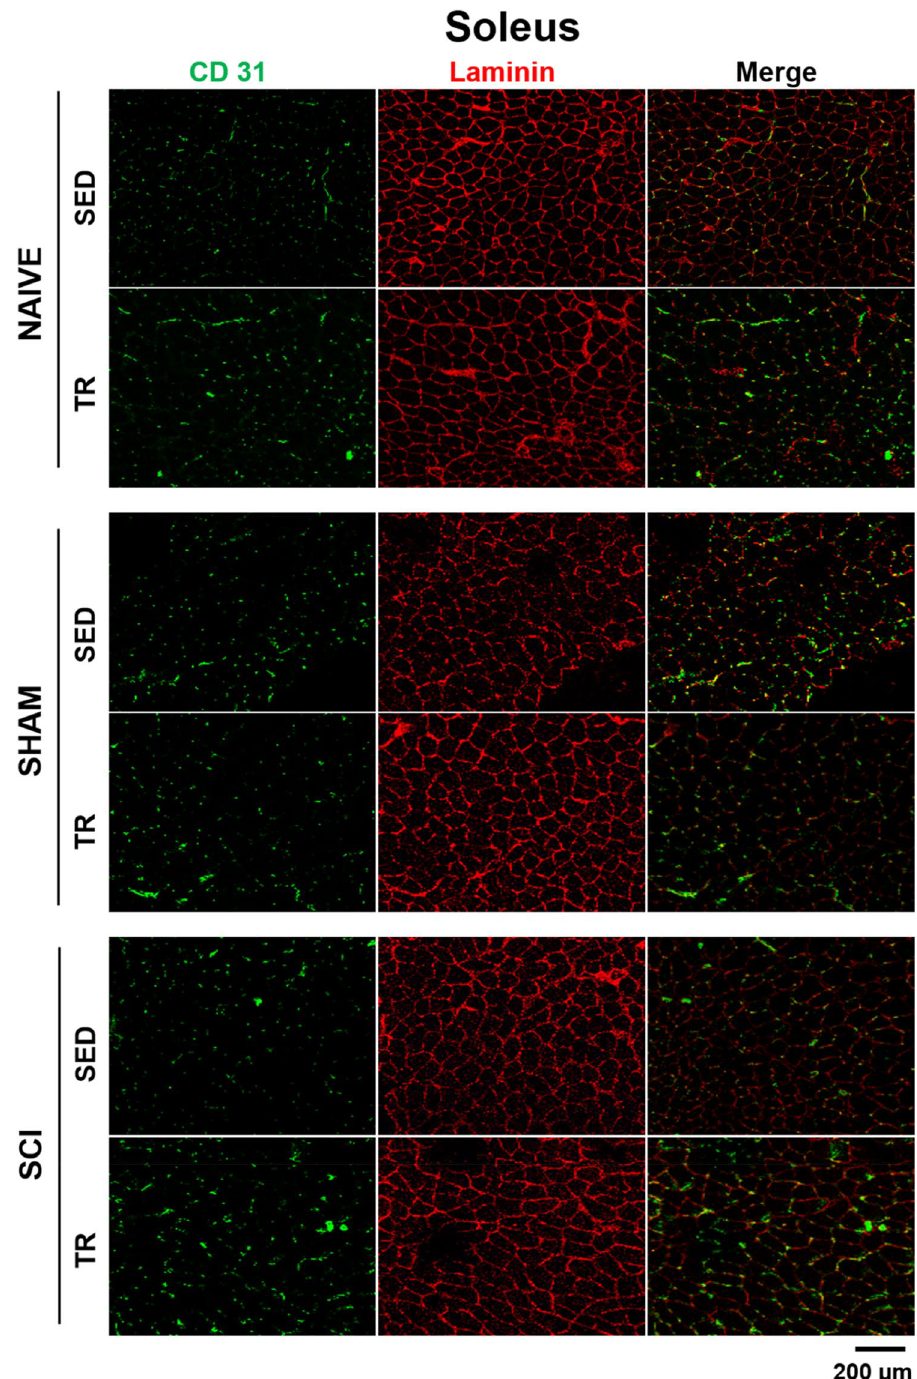
Figure 4. Representative images of CD31 expression and number of fibers in the skeletal muscles. Cryosections were immunostained to visualize CD31 (green) co-labeled with an anti-Laminin antibody (in red) in Soleus (SOL), while Extensor digitorum communis (EDC), Tibialis (TA) anterior are illustrated in supplemental Figs. 1 and 2, respectively. Scale bar = 200